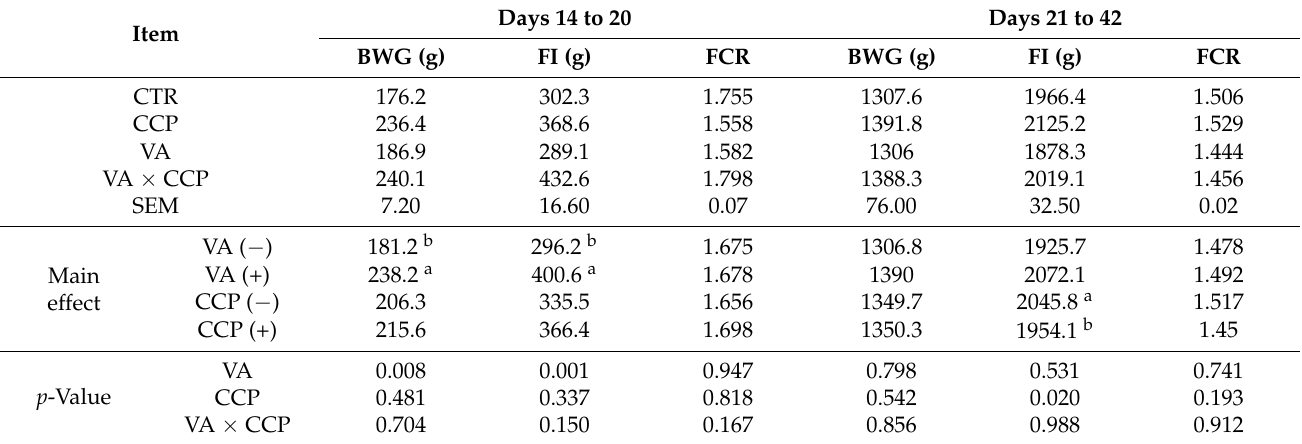
Table 3. The growth performance of broilers after the challenge (days 14 to